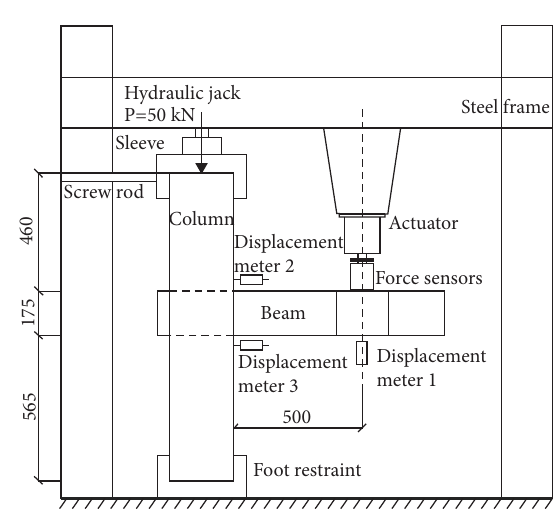
Figure 4: Experimental loading apparatus.